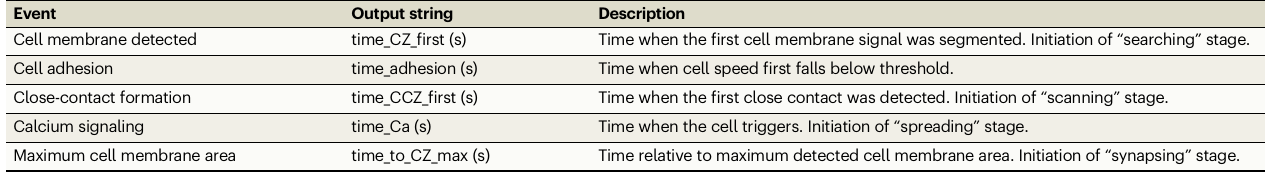
Table 2 | Interaction events